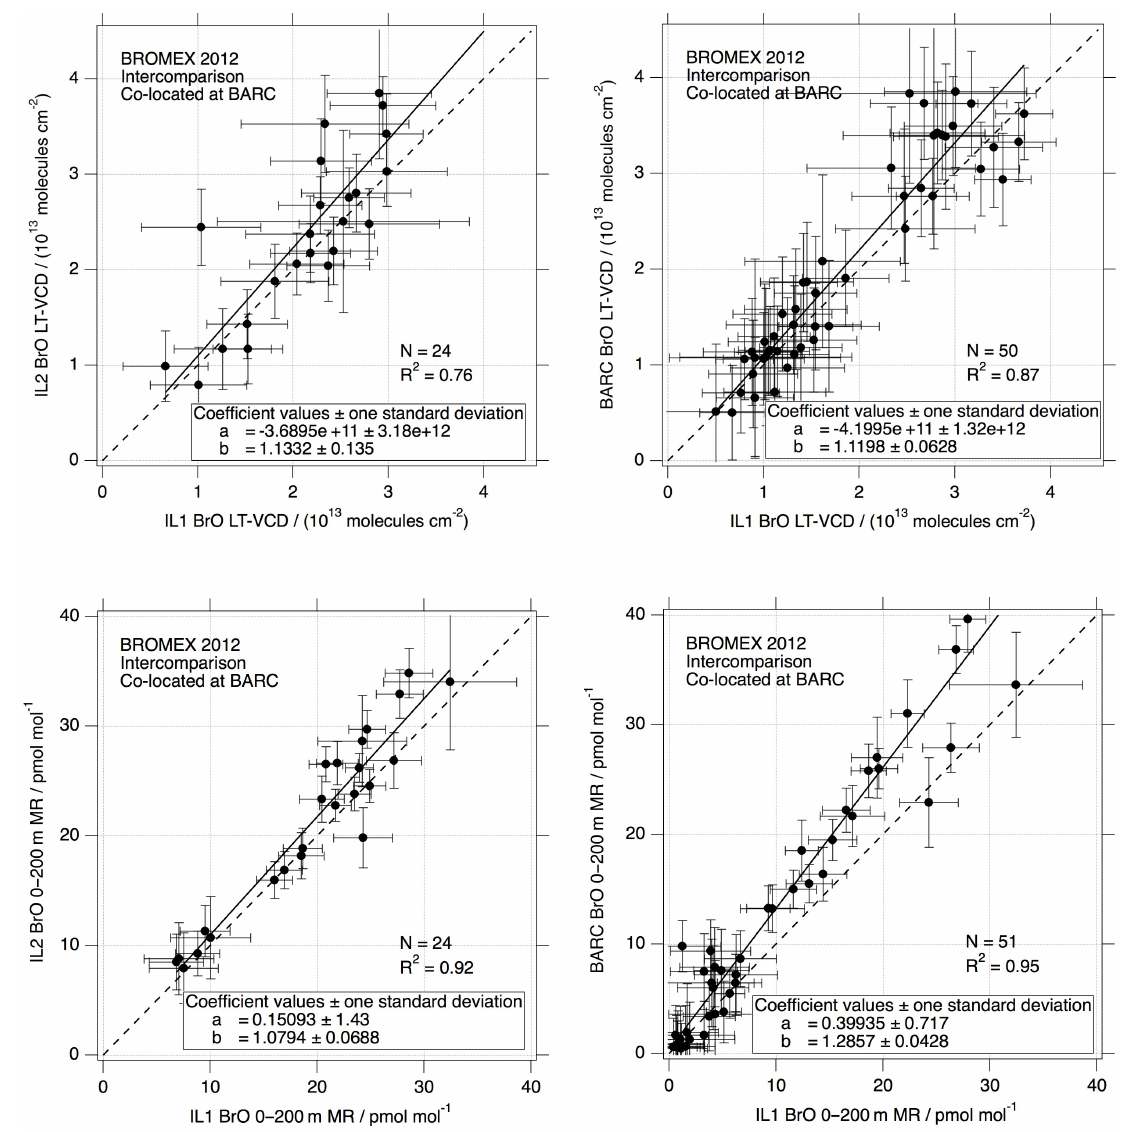
Figure 3. Intercomparison of BrO measurements between BARC, IL1, and IL2 when all instruments were co-located at BARC. Error bars (1 σ) are shown on each data point and were typically around 5 × 10 12 moleculecm − 2 for BrO LT-VCD and 3pmolmol − 1 for the BrO 0–200m mixing ratio